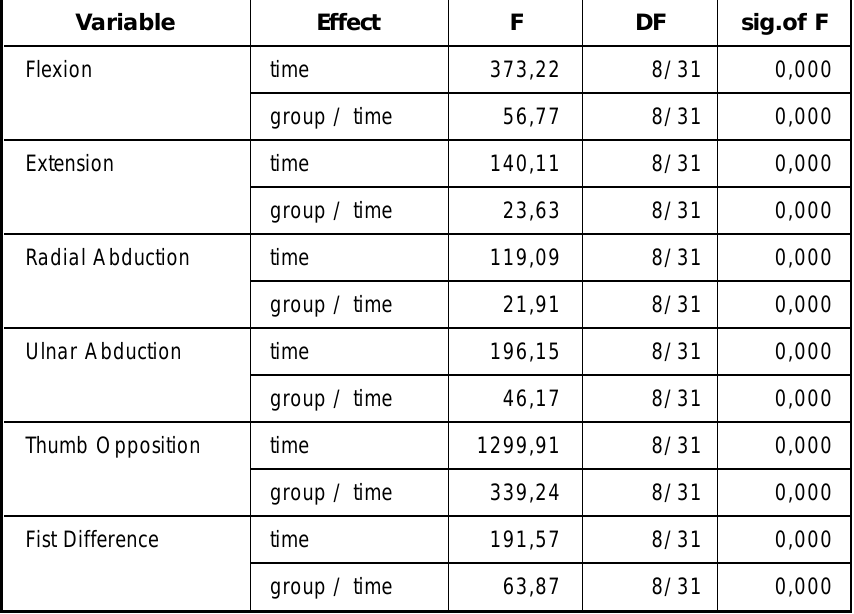
Table 4: Summary of Multivariate Tests (Wilks Roys) Results for Mobili- sation Parameters of the